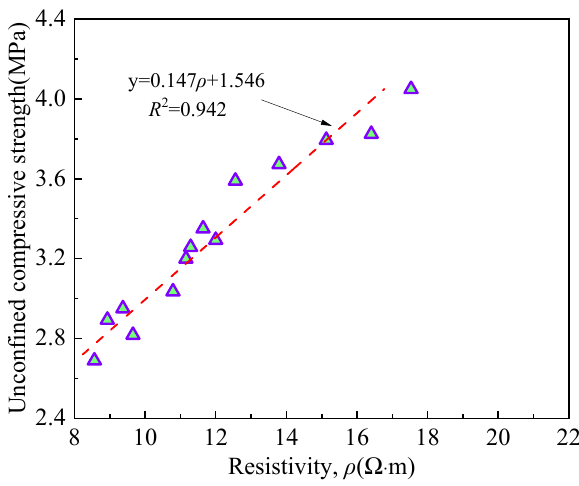
Figure 18. Relationship between resistivity and unconfined compressive strength.